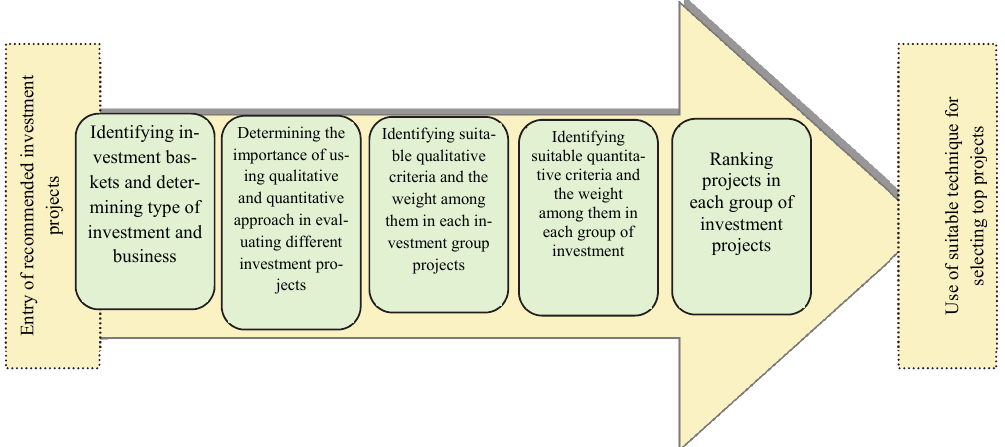
Fig. 2. Four steps for categorizing, evaluating and selecting investment